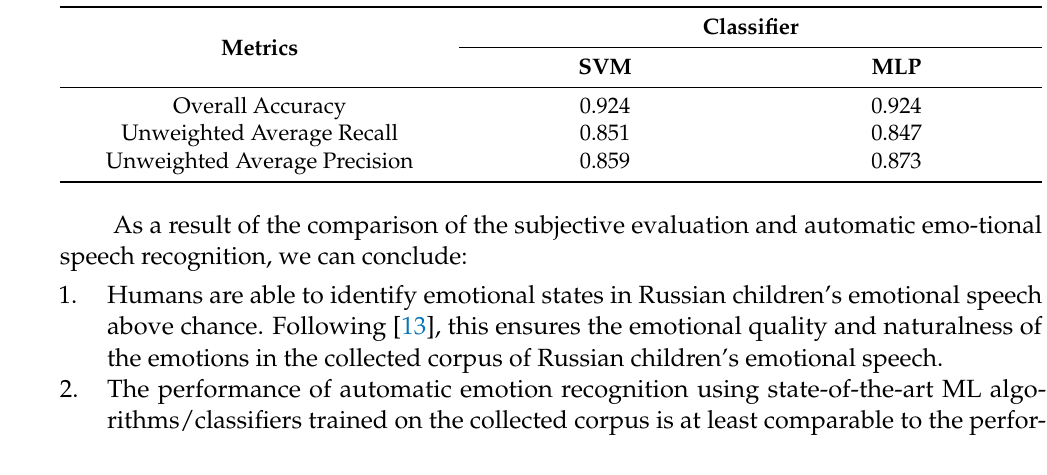
Figure 4. Confusion matrices for SVM and MLP classifiers, a dataset of Russian children’s emotional speech with 2505 samples for training, an eGeMAPS feature set, and an additional 33 samples from subjective evaluations for testing. Table 9. Overall scores in automaticmulti-class classification, eGeMAPS feature set, testing on 33 samples from subjective